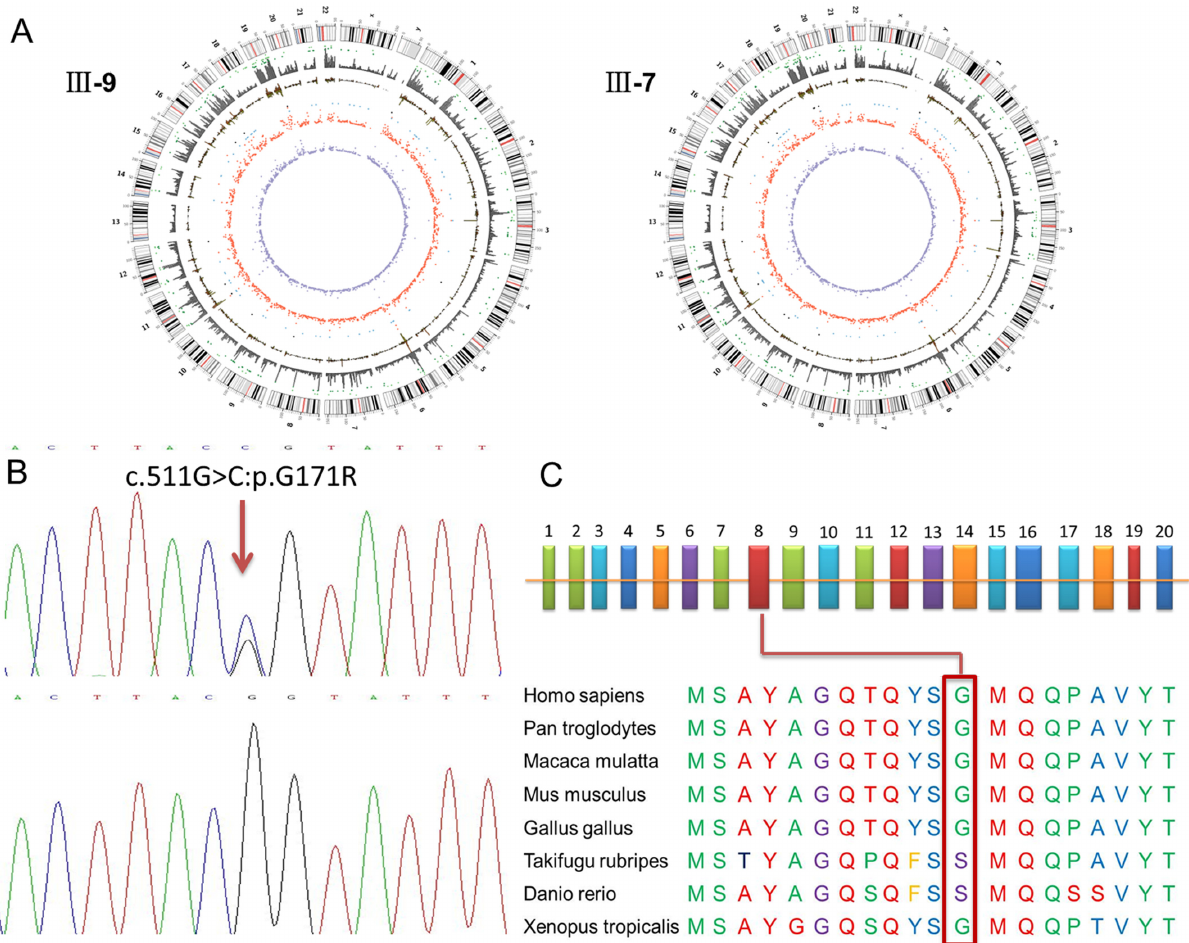
Fig 3. (A) Read coverage of each chromosome and mutation loci statistical results of the patients and of the normal control; (B) DNA sequence chromatograms presenting the two heterozygous missense mutations c.511G > C; p.G171R in affected individuals (upper panel) compared with the wild-type controls (lower panel). (C) The structure of the EYA4 gene. The EYA4 gene has 20 exons. The c.511G > C; p.G171R mutation identified in the EYA4 gene is in exon 8. The conservation analysis indicates that the Gly residue at 171 in the EYA4 protein is not conserved across Homo sapiens , Pan troglodytes